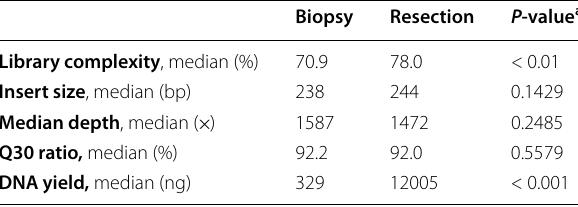
Table 2 Quality control for biopsy and resection specimens.